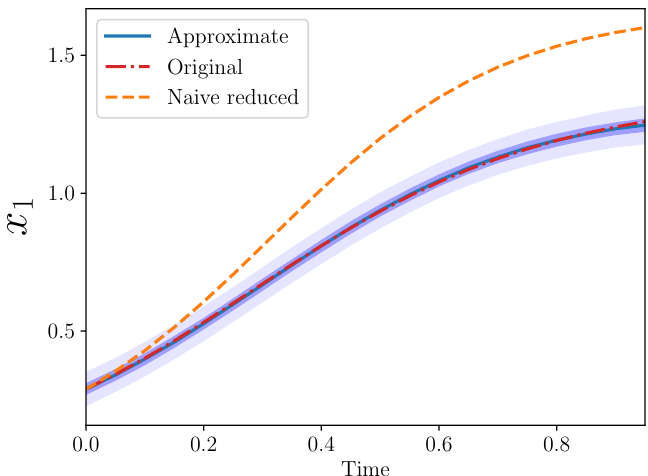
Figure 4. Approximate integral model for β = 2, α = 1.